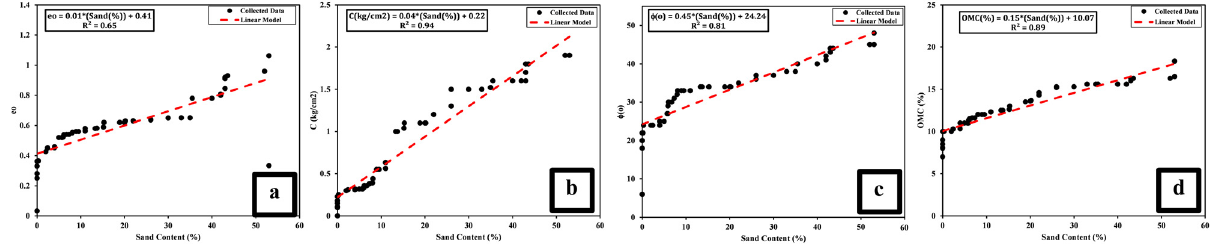
Figure 7: The variation in various soil characteristics vs sand content for Kirkuk city: ( a ) e o vs sand content ( % ) , ( b ) c ( kg/cm 2 ) vs sand content ( % ) , ( c ) ϕ vs sand content ( % ) , and ( d ) OMC ( % ) vs sand content ( % ) .